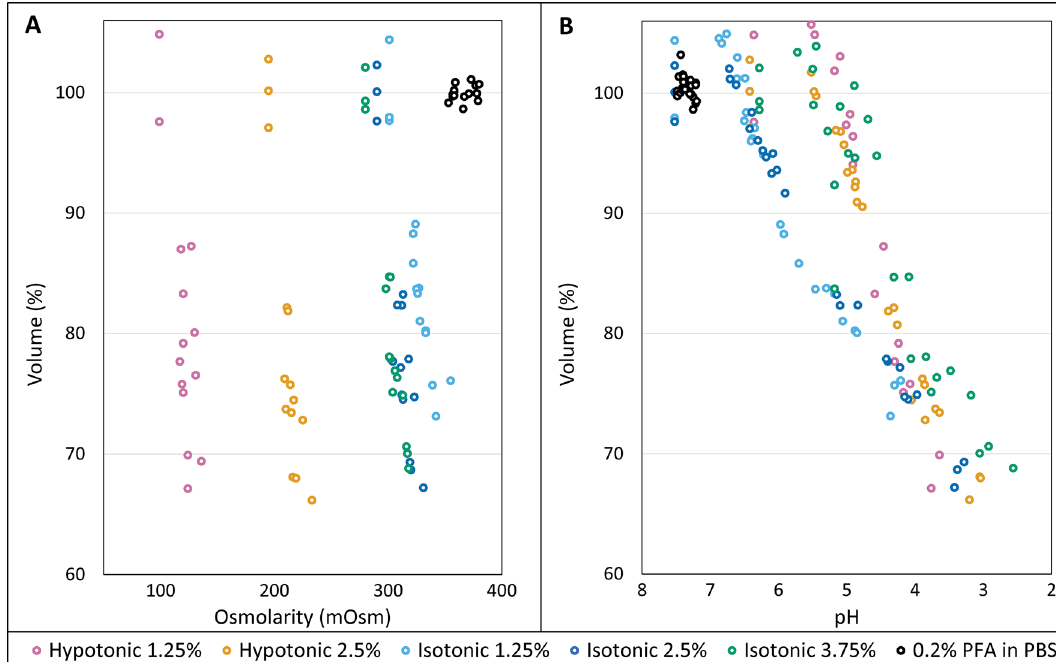
Figure 3. Scatterplots showing the relation between liver volume and osmolarity or pH of the staining solution. Observed liver volumes were normalized by setting the mean volume at time 0 to 100%. Each dot represents a mouse liver at a different time point. ( A ) Volume versus Osmolarity . The decrease in tissue volume in isotonic solutions (approximately 300 mOsm) was in the same range as in both hypotonic solutions (approx. 100 and 200 mOsm), showing no correlation between tissue shrinkage and osmolarity. ( B ) Volume versus pH. The decrease in tissue volume, tissue shrinkage, shows a similar trend with decreasing pH in each of the tested Lugol’s